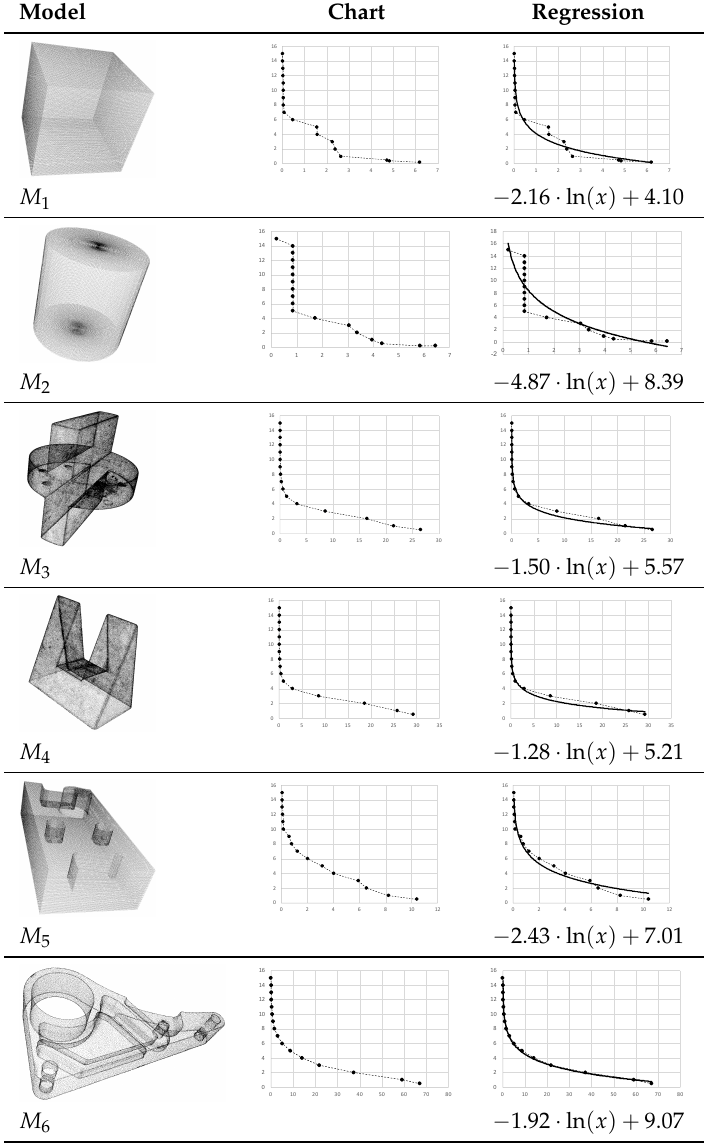
Table A2. Table of data and logarithmic regression for all testing point clouds. Model